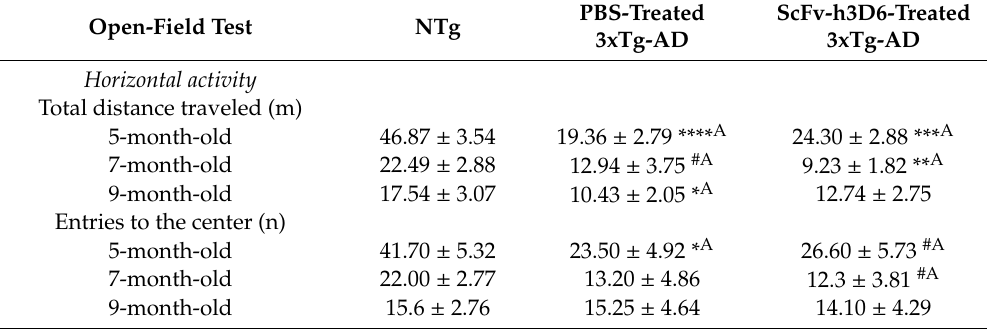
Table 2. Open-field test data. Values are expressed by means and SD. # indicates a low, but not significant, p -value 0.05 < p ≤ 0.1, * significant di ff erences with p ≤ 0.05, ** p ≤ 0.01, *** p ≤ 0.001, and **** p ≤ 0.0001. A refers to NTg / - mice, B refers to the 3xTg / - mice and C refers to the 3xTg / WT